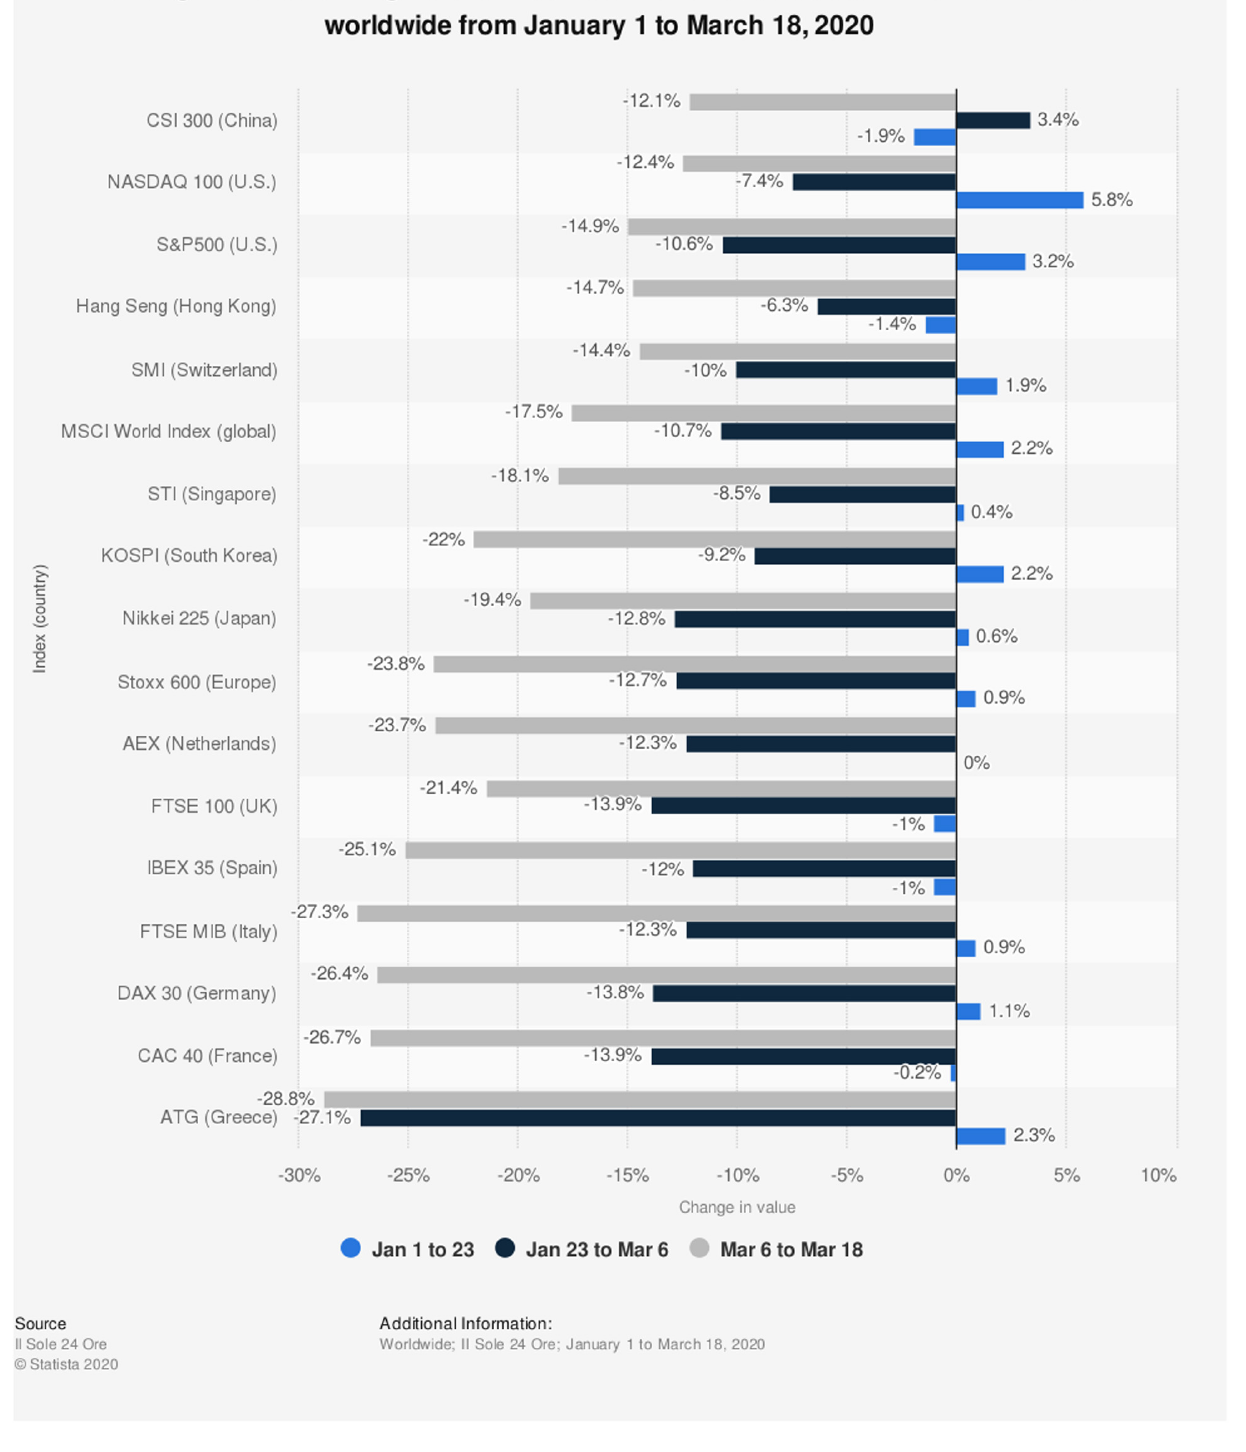
FIGURE 1 | Deterioration in the stock markets owing to novel coronavirus.